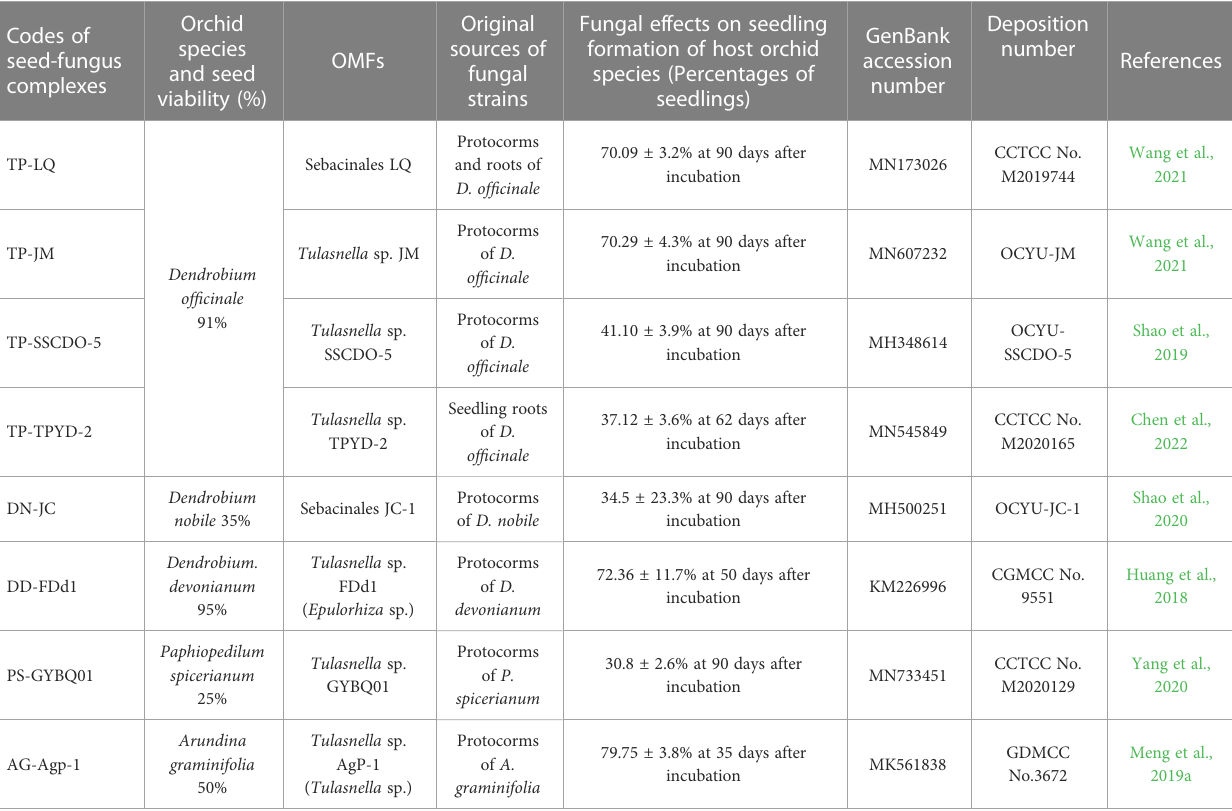
TABLE 1 The seed-fungus complexes of fi ve orchid species with eight orchid mycorrhizal fungi (OMFs) used in this study, including information on seed viability (%), the original sources of OMFs and their effects on seedling formation of host orchids reported in previous studies.